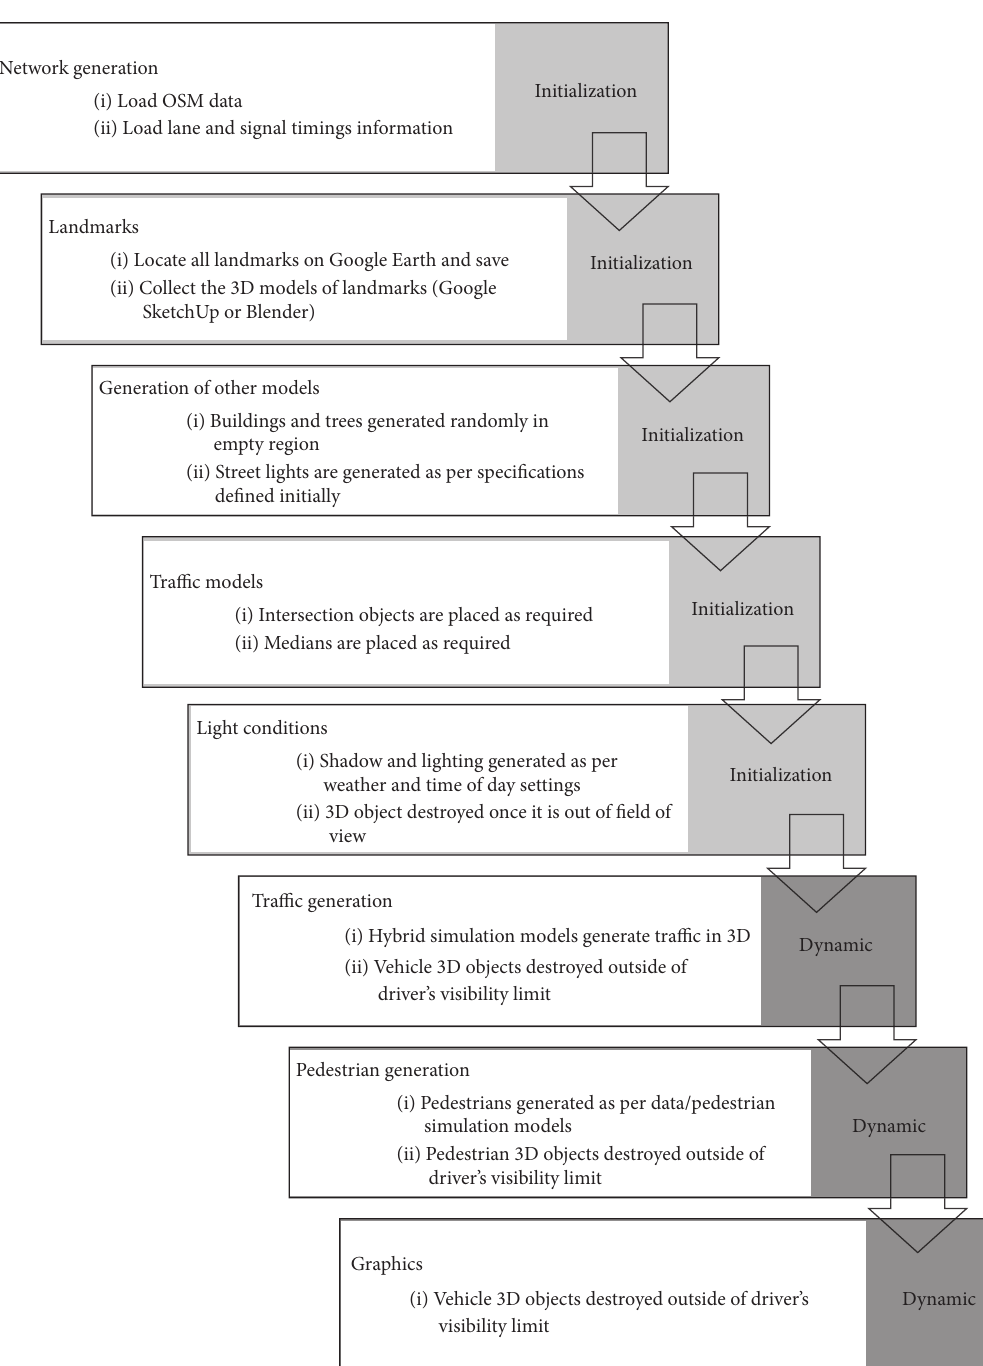
Figure 4: Layer-architecture for Virtual Reality